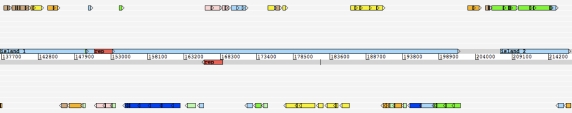
Diagram of the R. leguminosarum major nitrogen fixation gene cluster.This cluster represents a potentially laterally transferred region of DNA. Major nitrogen fixation genes and features are represented as blocks. The color key for the features shown is as follows: features labelled island_1 and island_2 show the two regions of potential horizontal gene transfer (light blue), nif structural genes for nitrogenase, nifDKHEN and fdxB, also nifAB (royal blue), fix genes, fixABCX and fixOPQGHIS (bright green gene cluster), gene products predicted to be membrane located (bright green, other), nod genes involved in nodulation (yellow gene cluster), genes involved in metabolism (yellow, other), rhiABC, rhiR and other potential regulators (light blue), repeats (dark pink), insertion sequences and transposon-derived (pink), pseudogenes and partials (brown), conserved hypotheticals (orange), hypothetical, no match (light green).